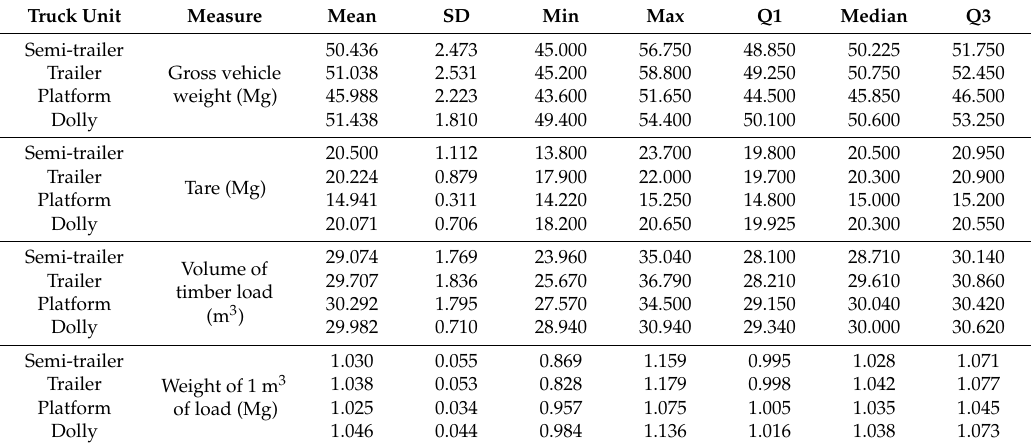
Table 1. Selected measurements by type of truck unit.